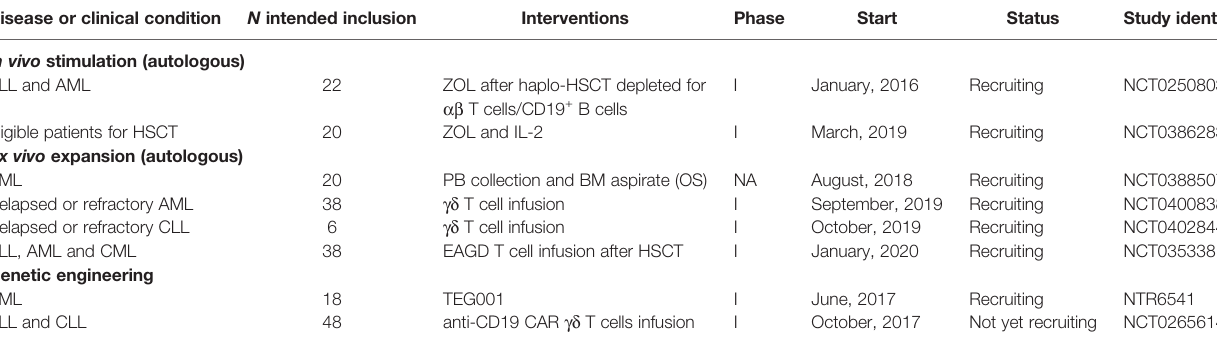
TABLE 3 | Currently registered gd T cell-based clinical